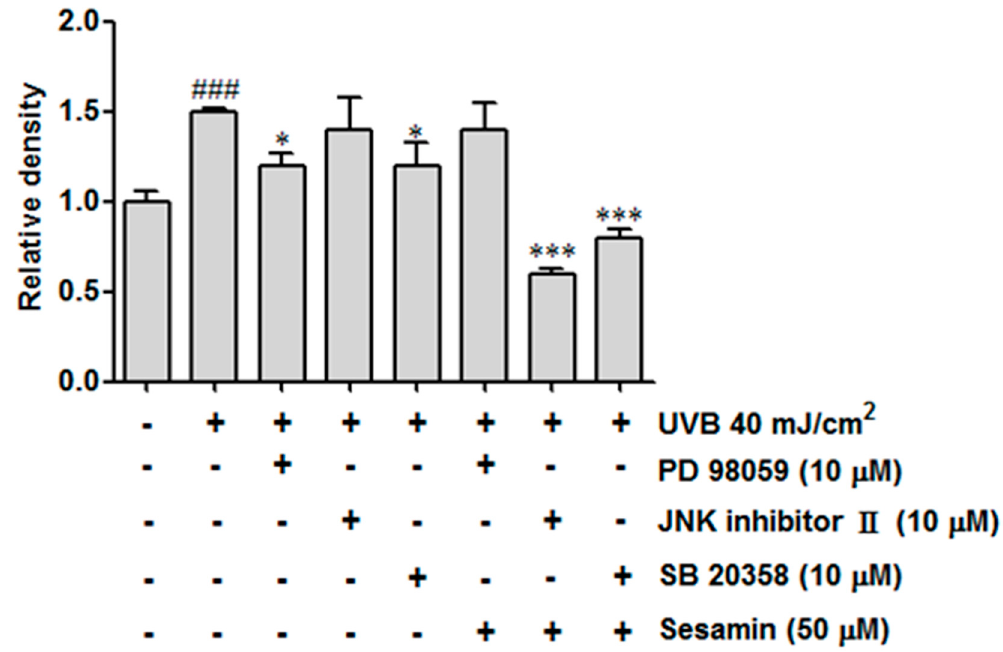
Figure 10. Effects of the MAP kinase inhibitor and sesamin on the UVB induced COX-2 expression in human skin fibroblasts. ### p < 0.001: Significant difference versus non-irradiation group. * p < 0.05; *** p < 0.001: Significant difference versus non-treatment group.